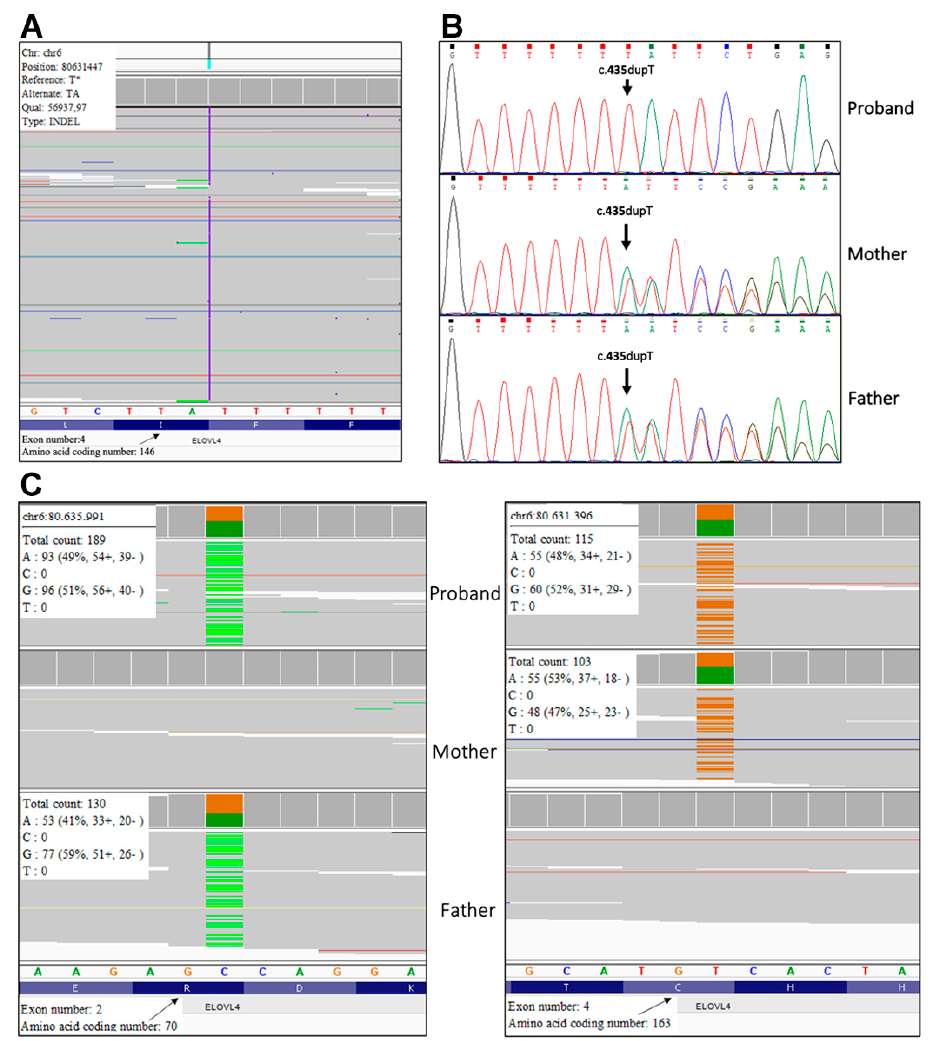
Figure 4. Molecular genetic testing. Next generation sequencing (NGS) singleton analysis shows the ELOVL4 (NM_022726.3) variant c.435dup, p.(Ile146Tyrsfs*29) at the homozygous state in patient 1 ( A ), and Sanger analysis confirms the presence of the same mutation in the homozygous proband and his heterozygous parents ( B ); trio-based NGS analysis identifies the ELOVL4 paternal variant c.208C>T, p.(Arg70*) (left image) and the maternal variant c.487T>C, p.(Cys163Arg) (right image) in patient 2 ( C